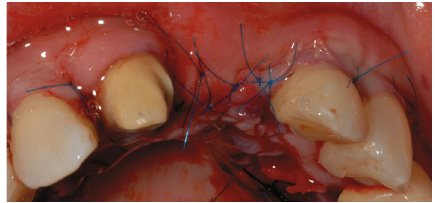
Figure 11: Suturing of the fl ap.